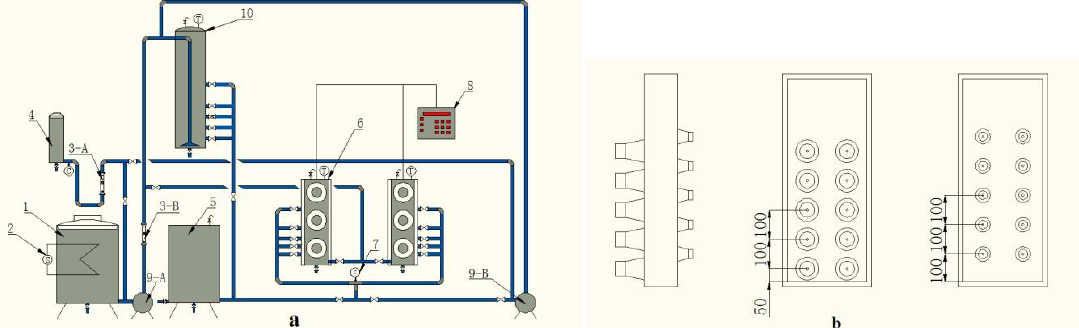
Figure 1. ( a ) Schematic of the ultrasound/chlorination water treatment system (1. Raw water container; 2. Heating equipment; 3A,B. Rotameter; 4. Chemical disinfectant container; 5. Treated water container; 6. Ultrasound (US) reactor; 7. Sample outlet; 8. Ultrasound (US) control board; 9A,B. Pump; 10. Chlorination reactor); ( b ) Scheme of the ultrasonic reactor [27].